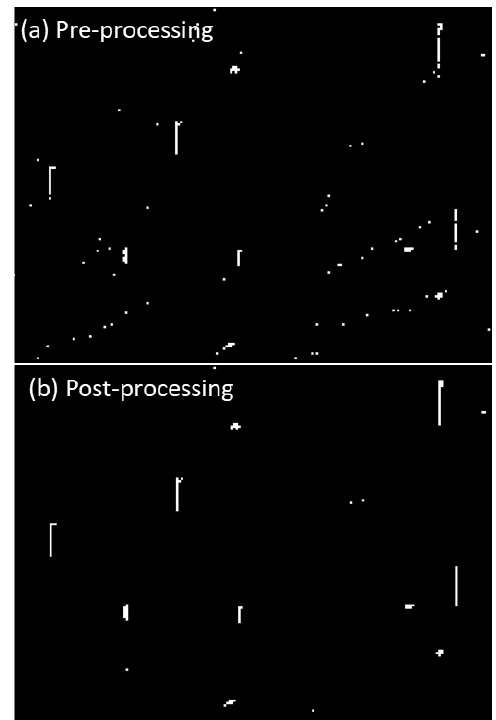
Fig. 6. A representative section of a CCD image produced under a 30-s exposure to a 210 Po source (a) before and (b) after processing to remove